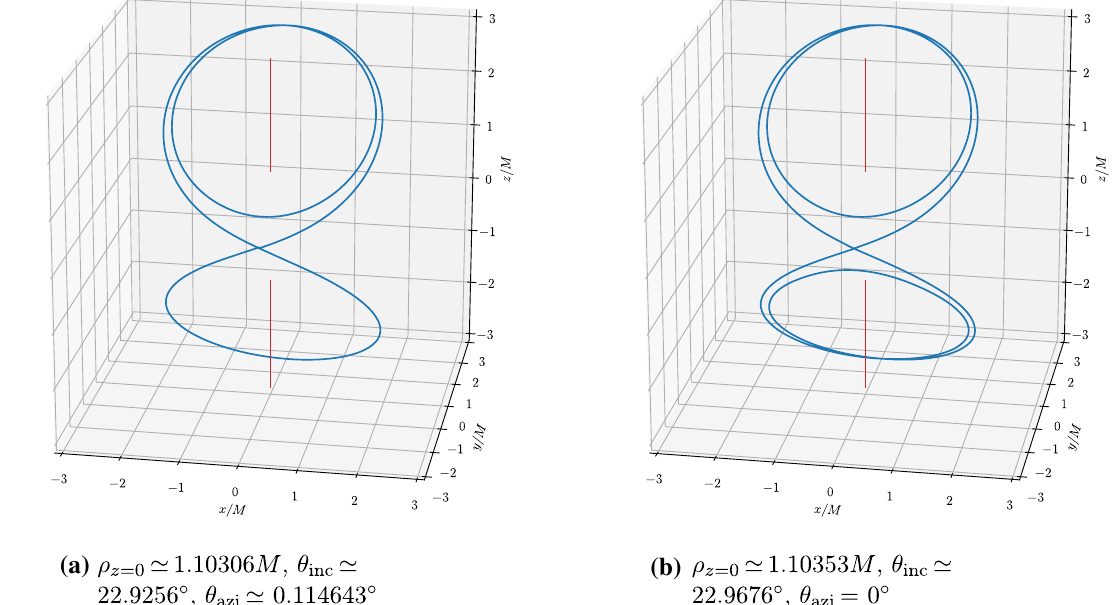
Fig. 12 Examples of higher-order non-planar FPOs, for the case L = M and (cid:9) = 6 . 5 M . The orbits start at the equatorial plane in both plots, and terminate after the interval (cid:10)φ = 6 π and 8 π ,